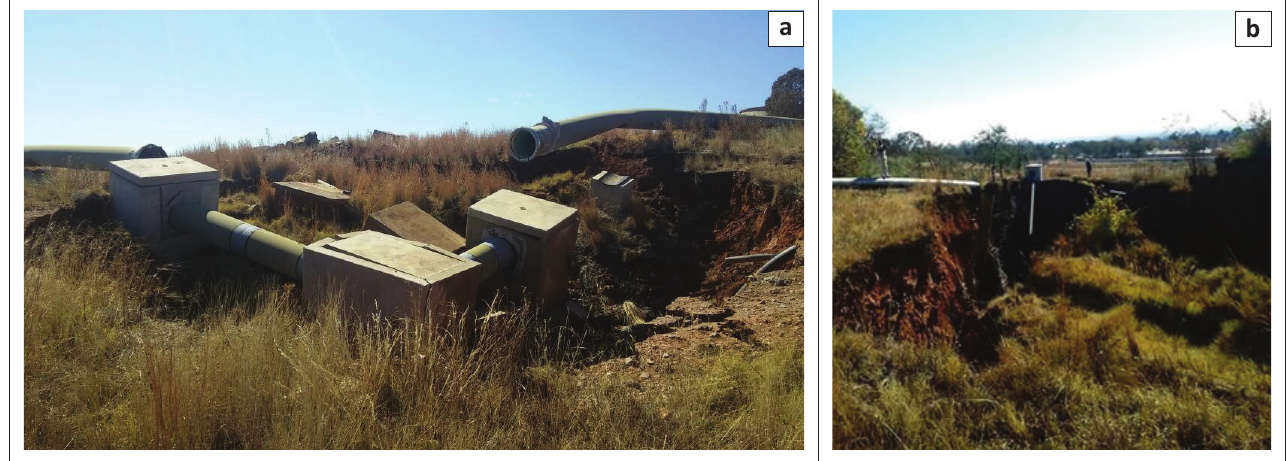
FIGURE 2: Some sinkholes in the Merafong City Local Municipality area.